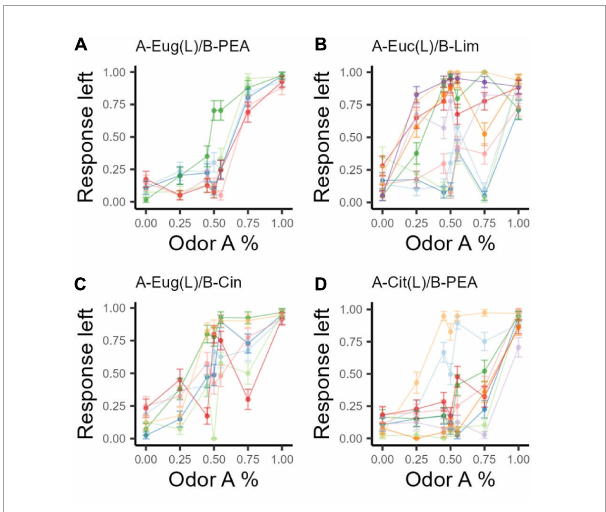
FIGURE2 Bootstrapped response intensity to the left port for each odor set. Based on the original binary response, grouping by odor set, rat, and combination ratio, we sampled with replacement (36 times to match number of data points in our original data) data points over 1,001 iterations. The response ratio to the left port of each rat on each combination ratio for each odor set is again calculated as (n go left/N total) for each odor combination ratio. Error bars are standard deviations. Colors indicate rat identities; each rat has the same color across panels. (A) n = 6, OS1: Eug/PEA; (B) n = 10, OS2: Euc/Lim, OS2 shows two clear subgroups, one group goes to the left port more than 50% of the time at 50A while the other group goes to the right; (C) n = 7, OS3: Eug/Cin; (D) n = 8, OS4: